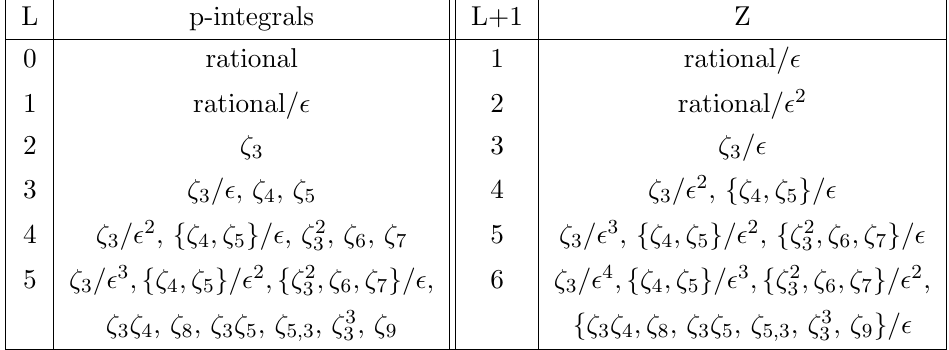
Table 1 . The structure of p-integrals (expanded in (cid:15) up to and including the constant (cid:15) 0 part) and RCs in dependence on the loop number L . The inverse power of (cid:15) stands for the maximal one in generic case; in particular cases it might be